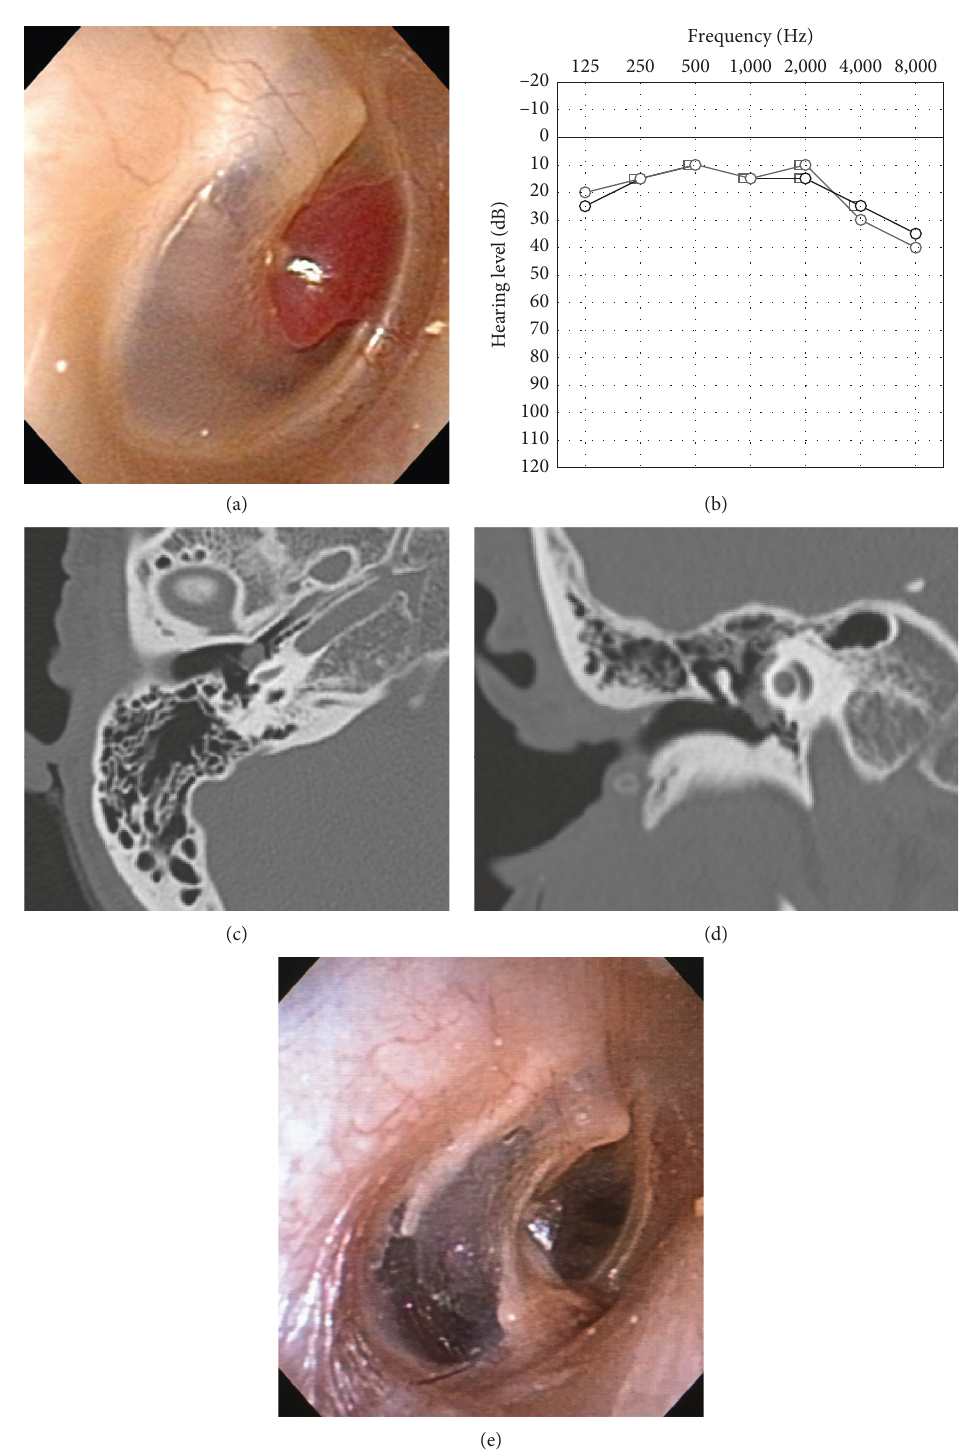
Figure 1: (a) A red mass was observed under the anterior quadrant of the tympanic membrane. (b) Pure-tone audiometry. The black and gray lines show the preoperative and postoperative hearing levels, respectively, in the right ear. After the surgery, the hearing level was not reduced and a normal hearing level was preserved. (c, d) A high-resolution computed tomography scan ((c) axial view and (d) coronal view) shows a mass on the promontory. (e) Postoperative tympanic